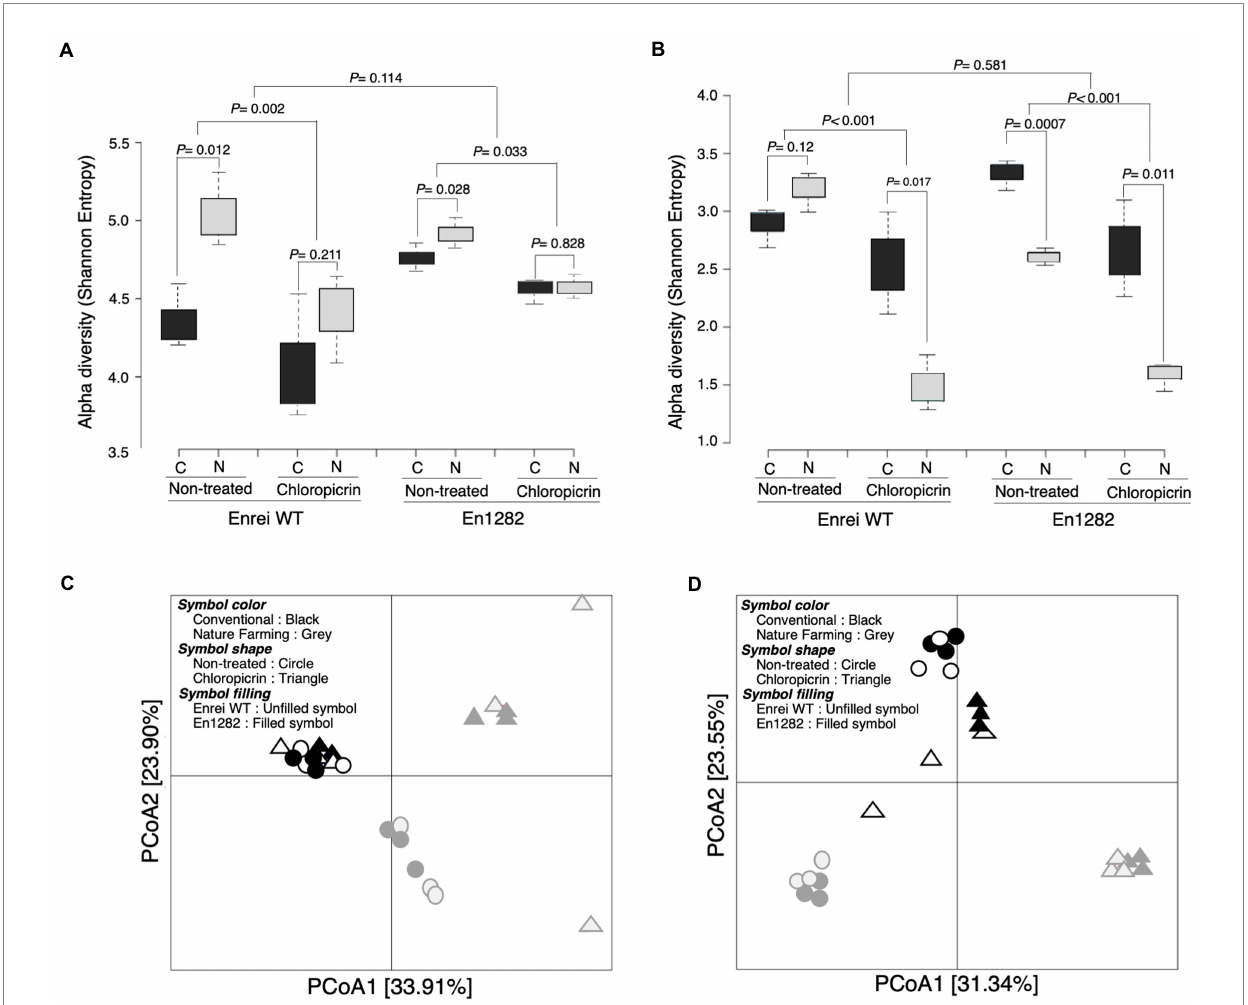
FIGURE 2 Rhizosphere bacterial and fungal community of soybean as influenced by cultivar, farming system, and chloropicrin treatment. Alpha diversity (Shannon index) of bacteria (A) and fungi (B) . Principal coordinate analysis (PCoA) based on Bray Curtis dissimilarity index for bacteria (C) and fungi (D) . C, conventional farming soil, N, nature farming